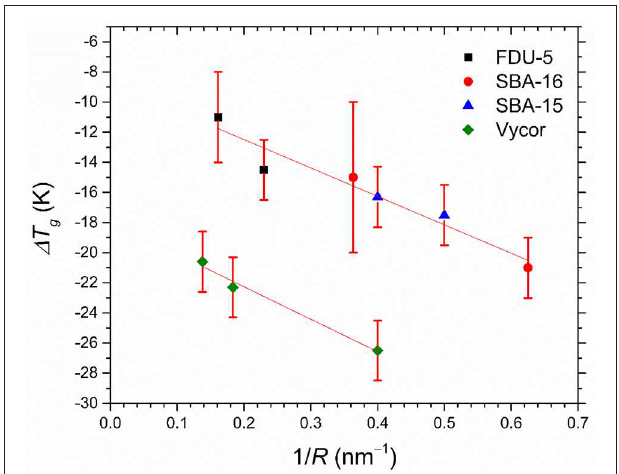
FIGURE 7 | Depression of T g of OTP nanoconfined in FDU-5 (black square), SBA-16 (red circle), SBA-15 (blue triangles), and Vycor samples (green diamonds) determined from the DSC scans, as a function of the inverse of pore radius R . Straight lines through the data are guide to the